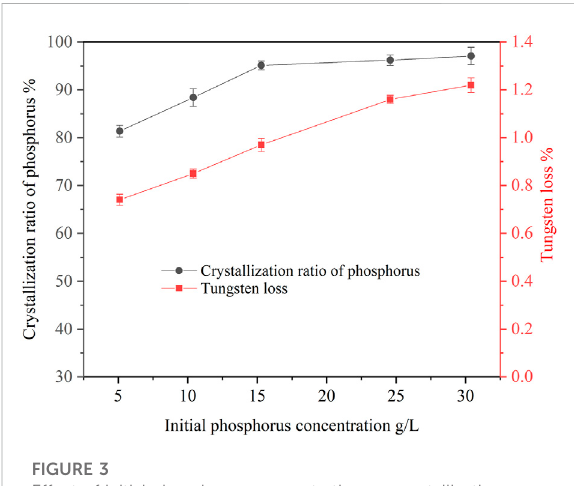
FIGURE 3 Effect of initial phosphorus concentration on